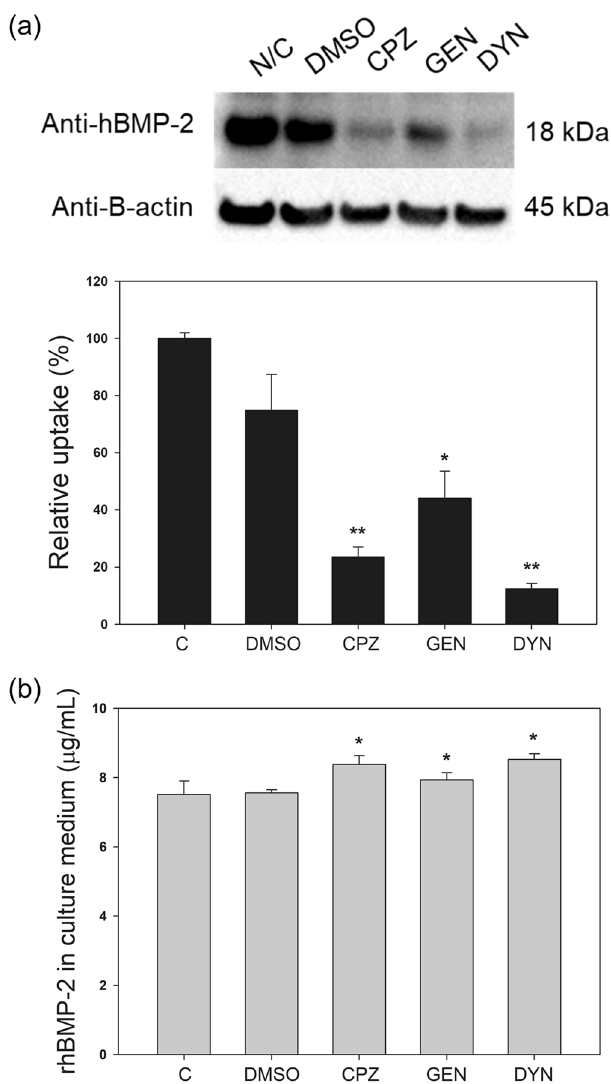
Figure 6. Effects of endocytosis inhibitors on rhBMP-2 internalization in DG44 cells. ( a ) Western blot analysis of intracellular rhBMP ‐ 2 in cells without any treatment as a control (C) and cells pre-incubated with DMSO as a vehicle control, chlorpromazine (CPZ,30 μM), genistein (GEN, 200 μM), or dynasore (DYN, 100 μM) for 30 min before addition of rhBMP-2 (top). β ‐ actin was used as the loading control. The relative rhBMP-2 uptake (%) was normalized to the rhBMP-2 uptake of C (100%, bottom). ( b ) The rhBMP-2 concentration in the culture medium after 3 h of incubation. The error bars indicate standard deviations calculated from the data of three independent experiments. *p < 0.05, *p <